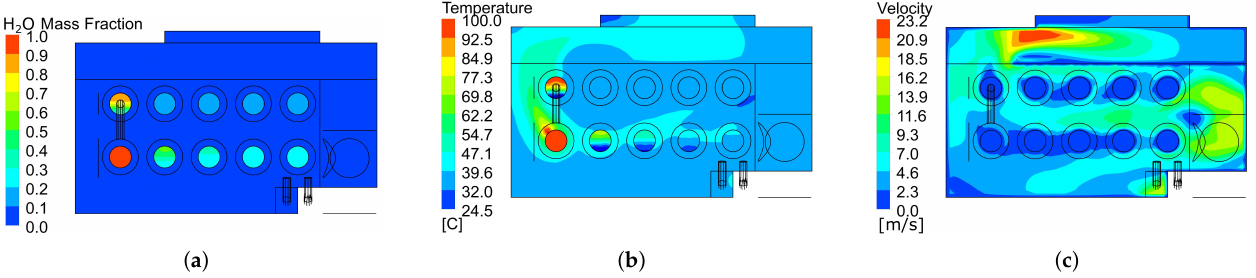
Figure 10. V2 cross-section: ( a ) H 2 O mass fraction; ( b ) temperature distribution; ( c ) velocity